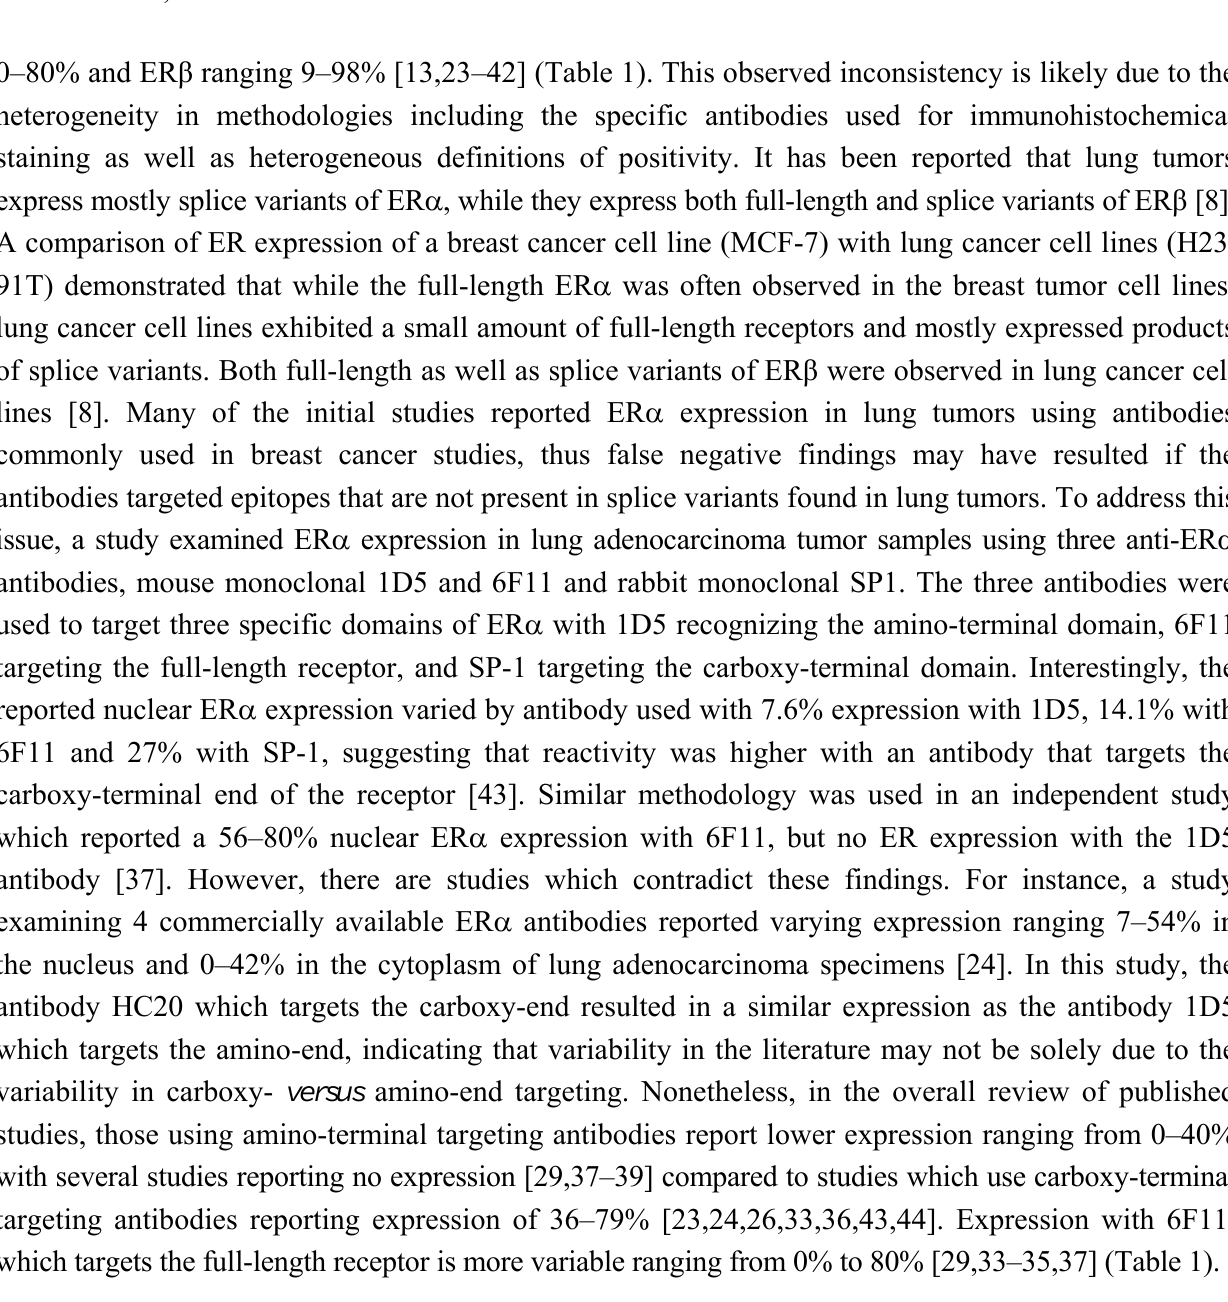
Table 1. Selected review of estrogen and progesterone receptor expression in